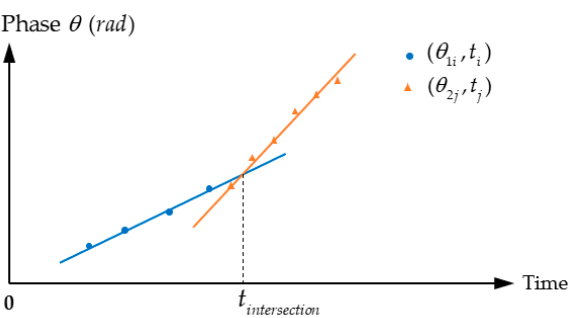
Figure 15. A function diagram of received BFSK signal phase verse time if using phase measurement method.